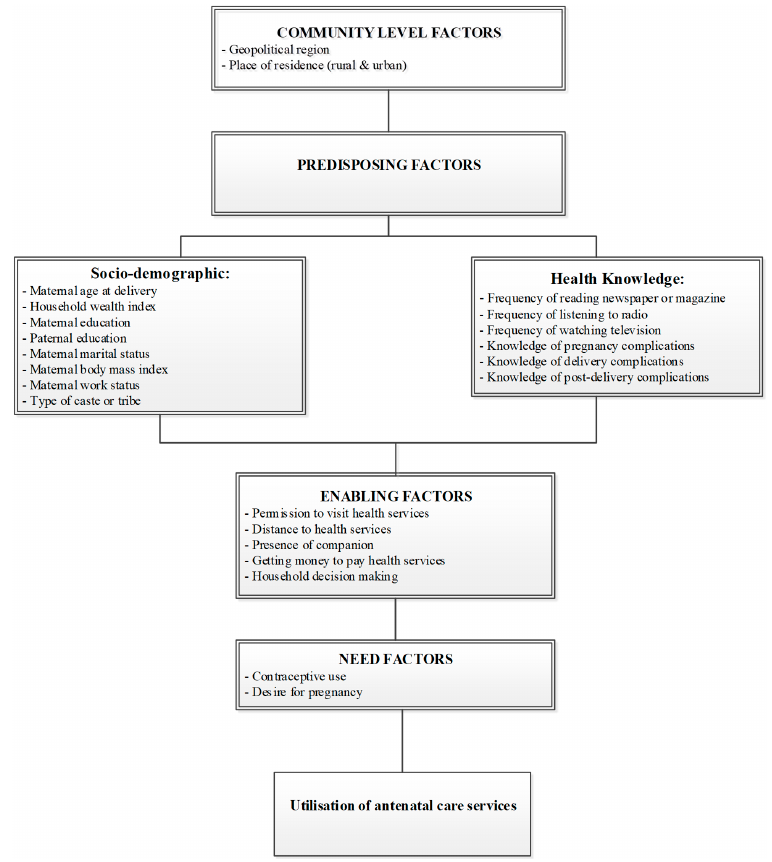
Figure 1. Conceptual framework modified from the Andersen behavioural model [23].